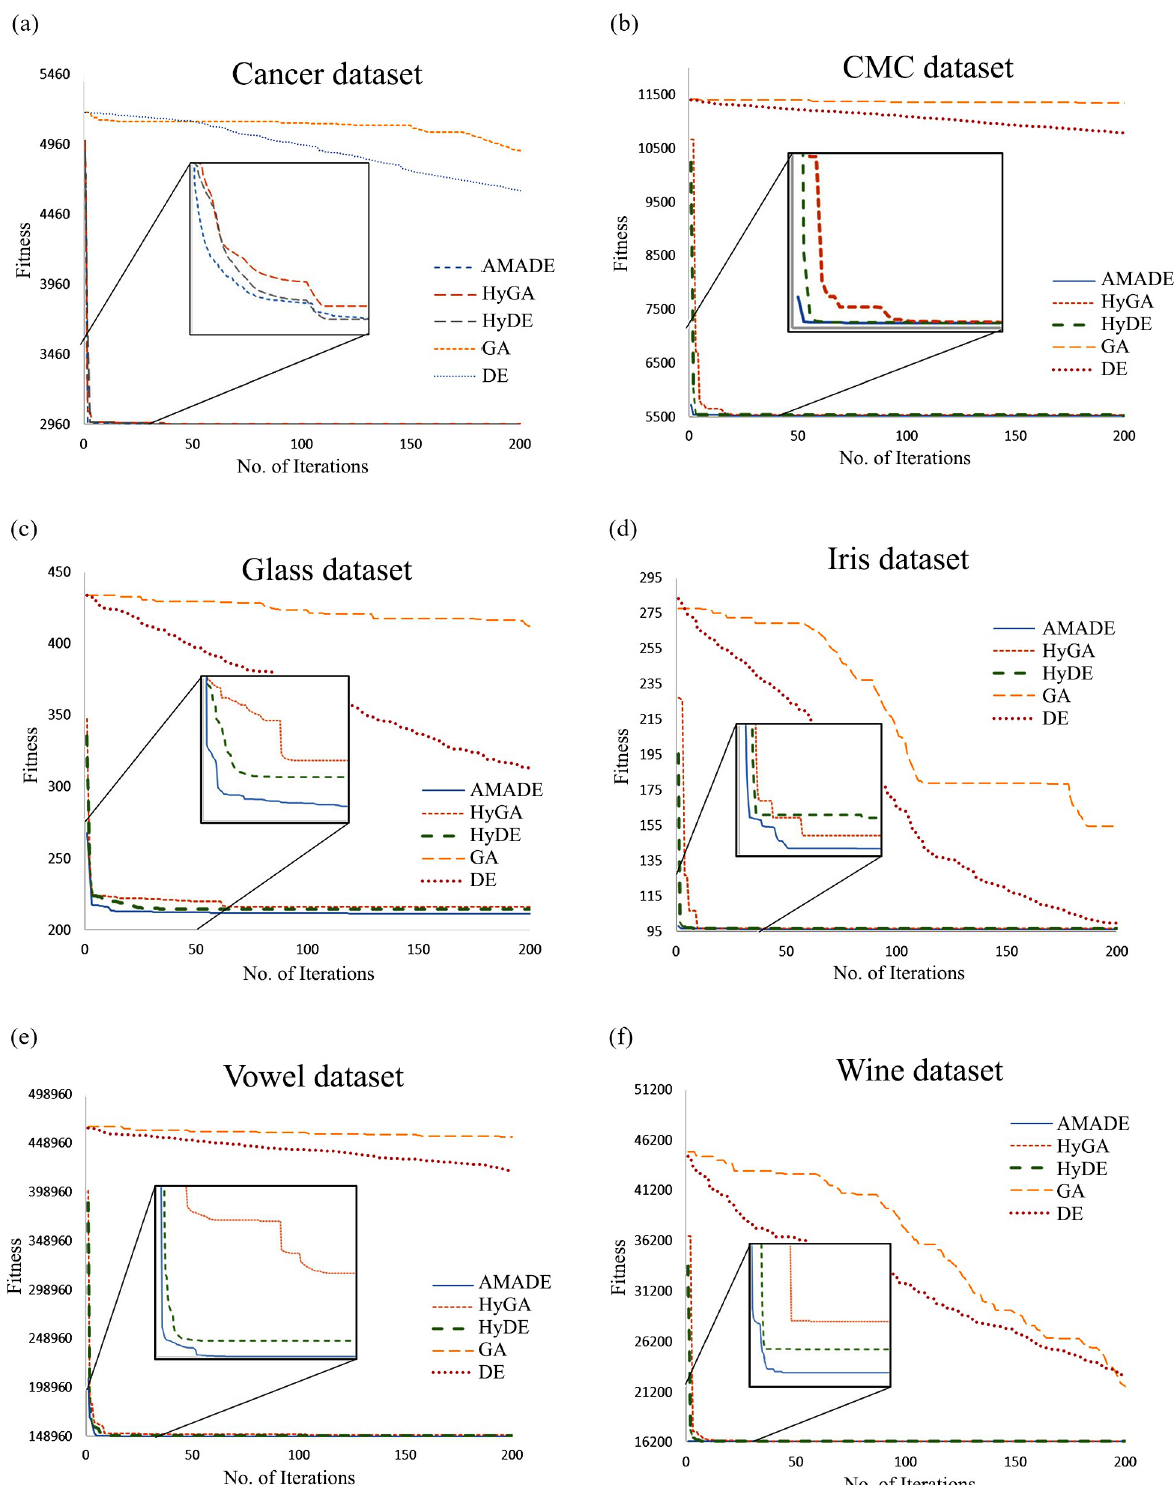
Fig 14. The convergence curves for the first 200 iterations on (a) cancer, (b) CMC; (c) glass; (d) iris; (e) vowel; (f) wine datasets.